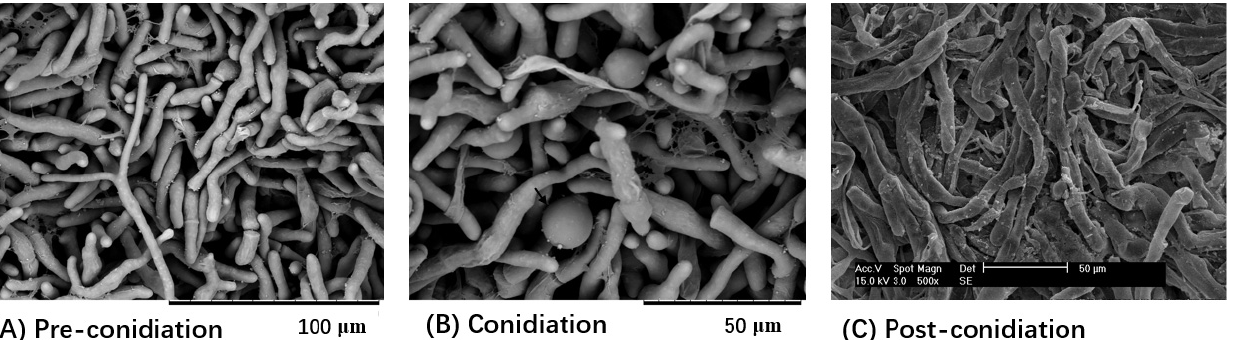
Figure 7. Scanning electron microscopy images of C. obscurus mycelium before, during, and after conidiation. For observing the morphological characteristics of C. obscurus in different stages of conidiation, the mycelial samples were collected. After fixation, dehydration, and platinum ion plating, the specimens of the mycelial mats of three conidiation stages were separately observed with Philips XL30-ESEM environmental scanning electron microscope (SEM). ( A ) Fresh liquid-cultured mycelia in the pre-conidiation (pre-C) stage; ( B ) Conidiation mycelia with global conidia on the tips; ( C ) Shriveled mycelia post-conidiation (post-C).